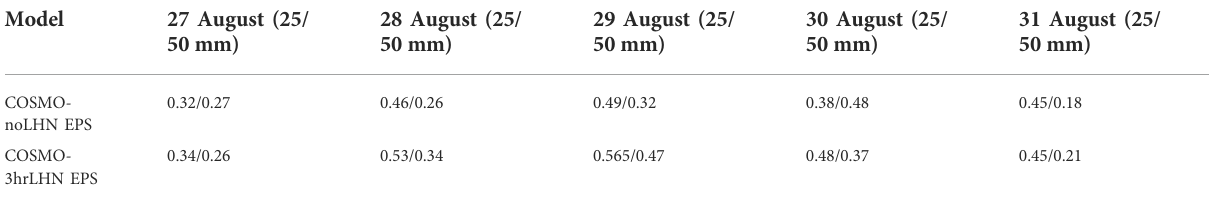
FIGURE 10 Spatial distributions of cumulative precipitation in Guangdong Province during the period of 27 – 31 August 2018 (precipitation of the fi rst 3 h are removed of each day) for (A) the observations, (B) the ensemble median forecast of COSMO- 3hrLHN EPS, and (C) the ensemble median forecast of COSMO- noLHN EPS.